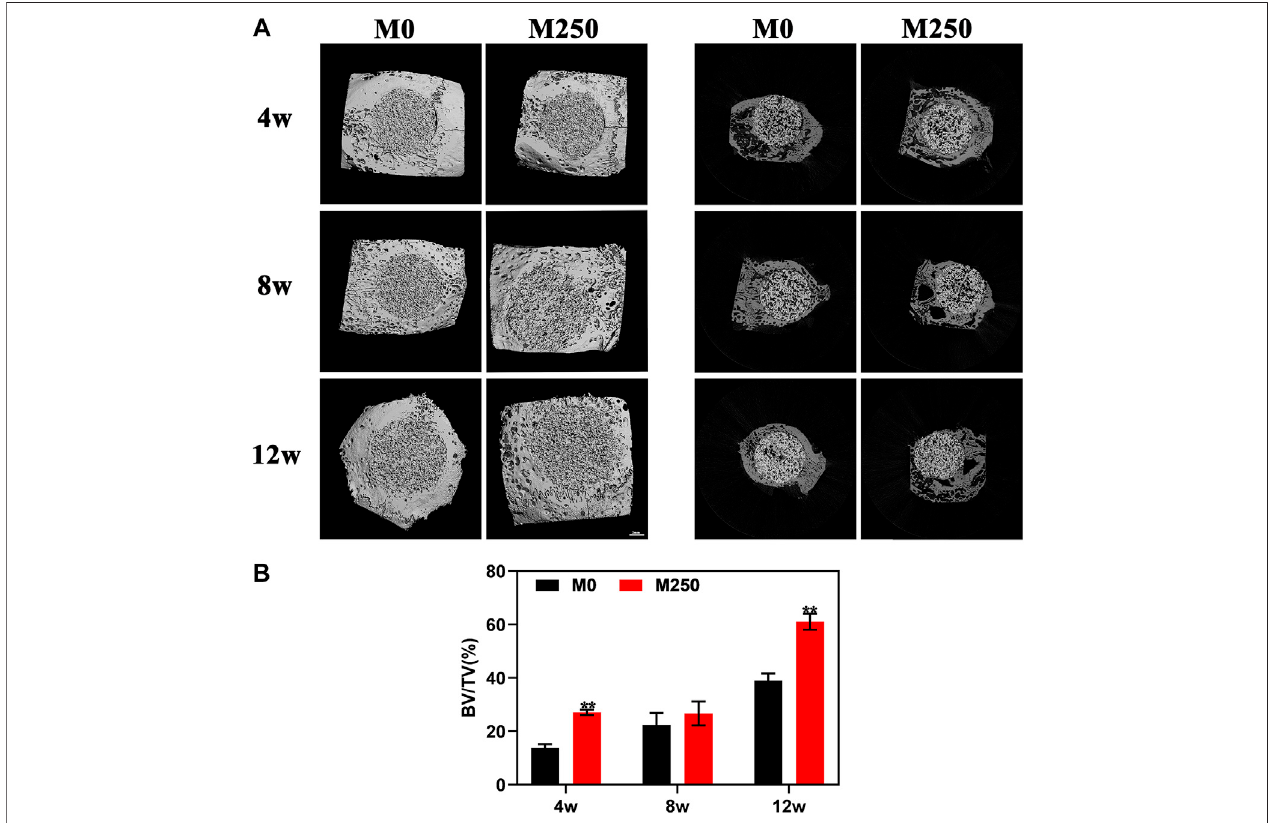
FIGURE7| Micro-CTanalysisofM0,M1250aftercalvarialimplantationfor4,8,and12 weeks. (A) Thecorrespondingthree-dimensionalreconstructionimagesof micro-CT results and representative axial sections. (B) Calculated bone volume/tissue volume (BV/TV) (Statistically signi fi cant differences are marked by * p < 0.05, ** p <